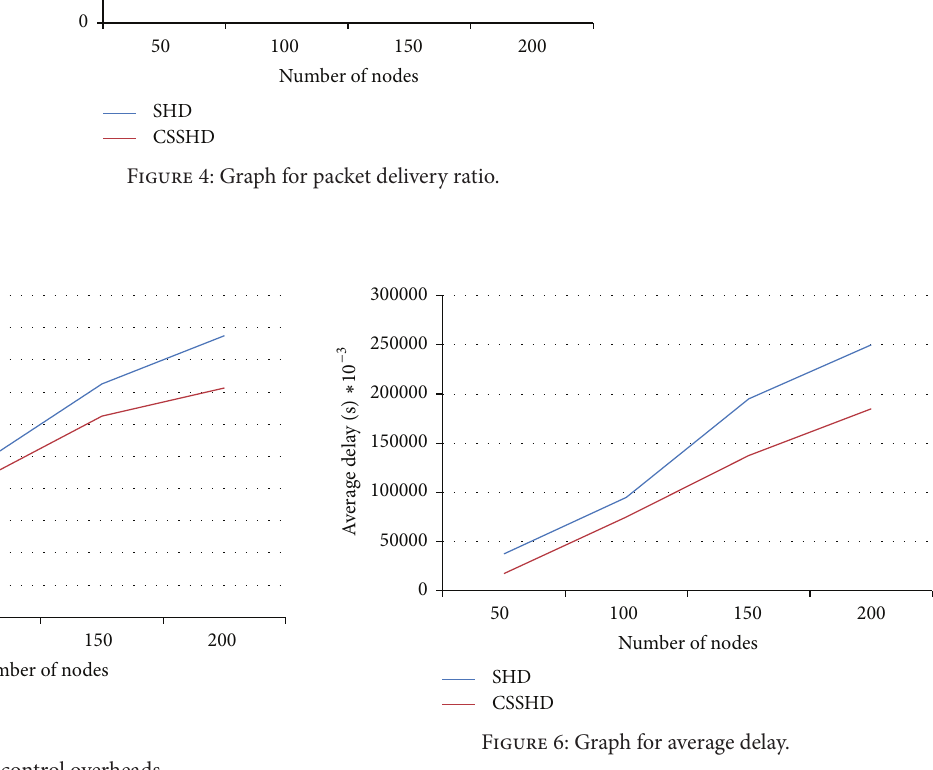
Figure 5: Graph for control overheads.